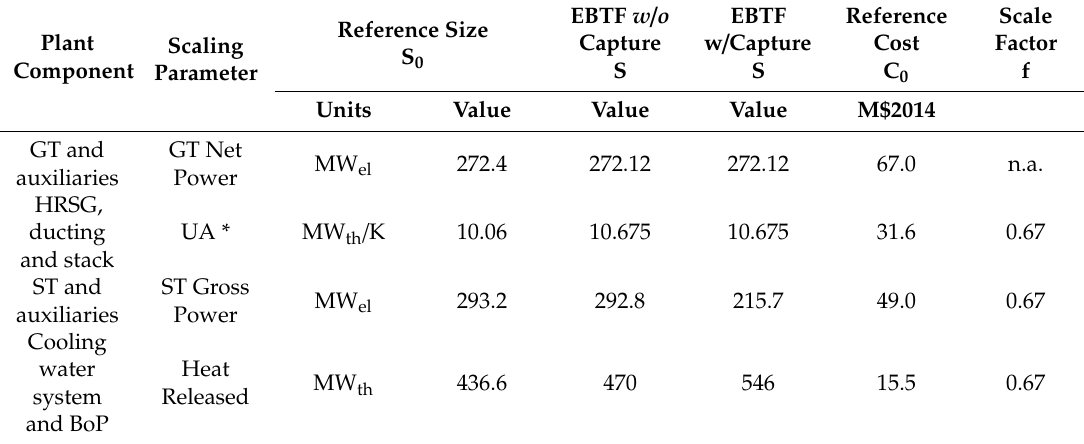
Table 5. References for Total Equipment Cost (TEC) evaluation of the reference